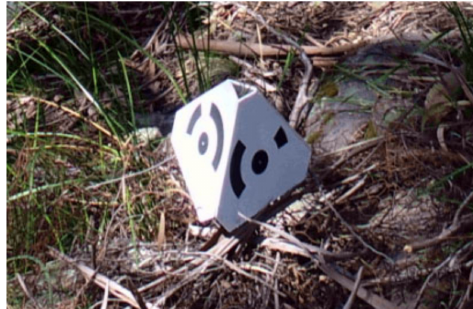
Figure 6. Tetrahedron-shaped coded target markers can be quickly deployed in the field to assist the image alignment process. Such coded targets can be automatically detected in Agisoft Metashape and are treated as true matches in the alignment